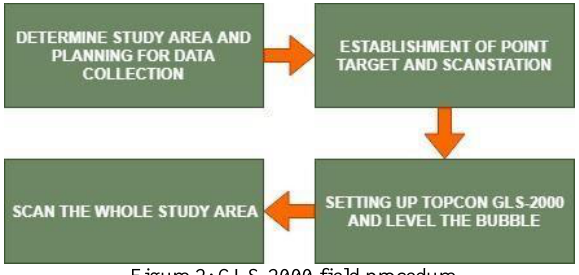
Figure 2: GLS-2000 field procedure